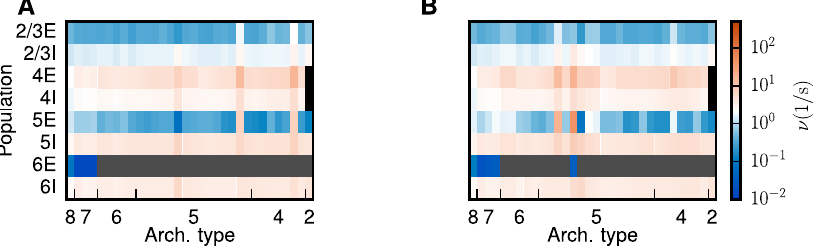
Fig 6. Unstable fixed points in subsequent iterations. Populationfiring rates at the unstable fixed point as predicted by the mean-field theory encodedin color for iterations 1 ( A ) and 2 ( B ). Same displayas in Fig